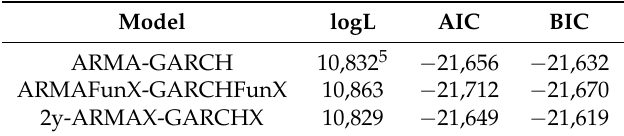
Table 4. logL, AIC and BIC, corresponding to the restricted models from Table